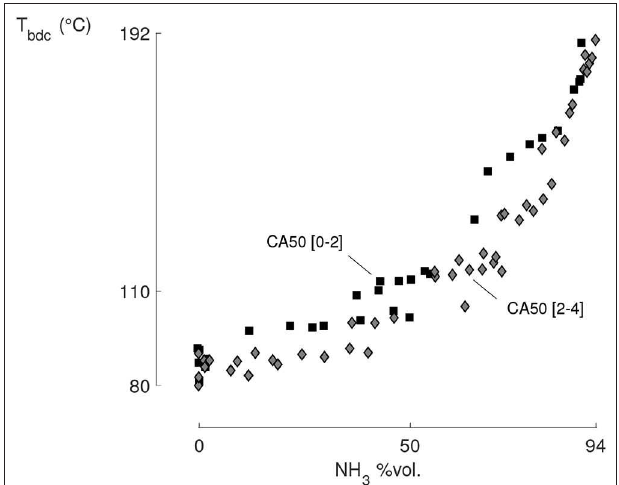
FIGURE 3 | The required BDC temperature is increasing exponentially with the ammonia fraction in the fuel (all experimental points, CA50 timings between 0 and 4 CAD). From the operator point of view, an increase in the supplied intake temperature from 50 to 235 ◦ C was needed.